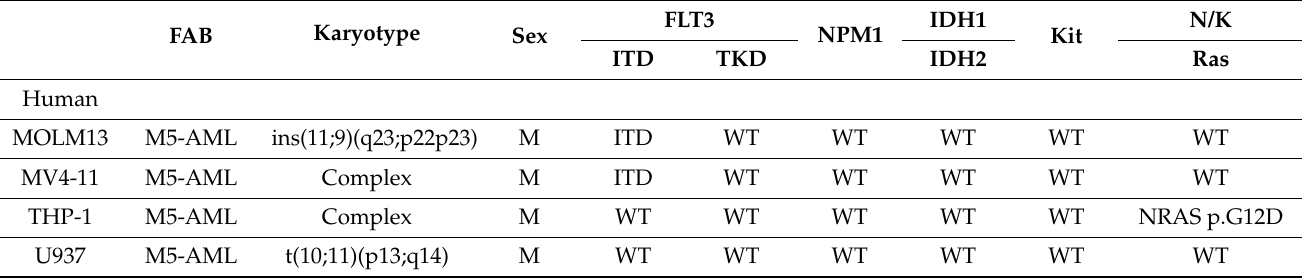
Table 1. Clinical and mutational information about the AML cell lines used in this